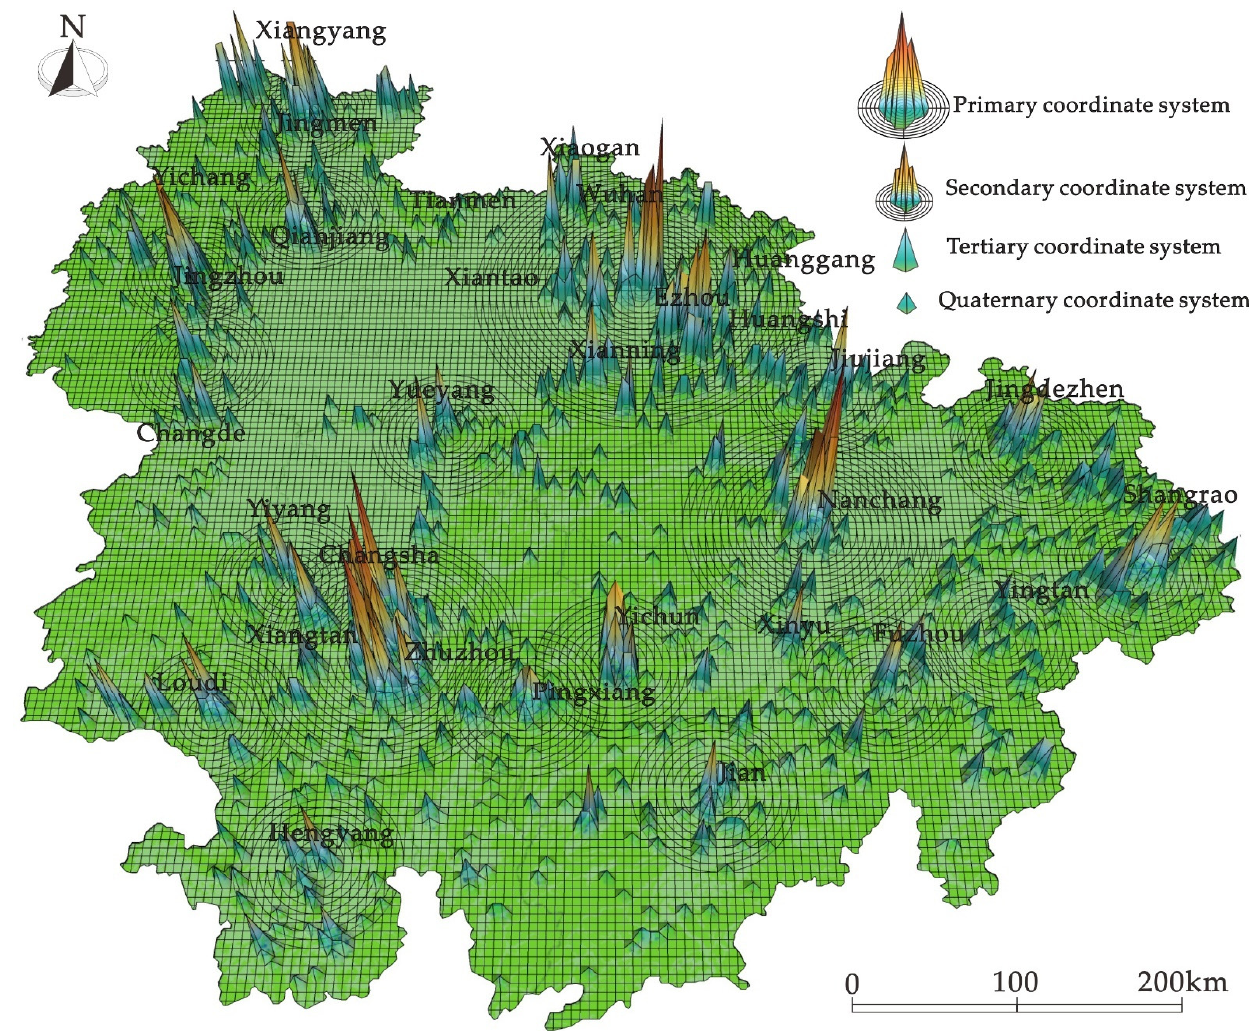
Figure 7. Coordinate systems of forest loss.